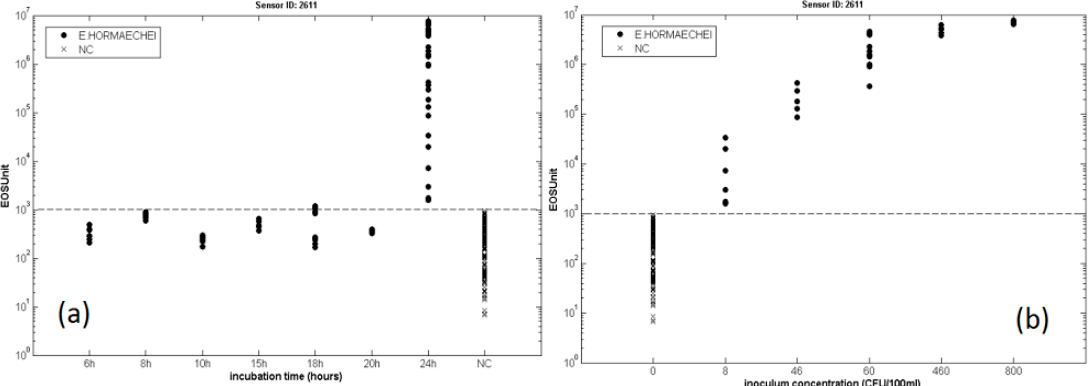
Figure 18. ( a ) plot of the sensor 2611 EOS units against the sample incubation time from 6 h to 24 h. C and NC samples are labelled in different ways (dots vs. crosses); ( b ) plot of the sensor 2611 EOS units as a function of the inoculum concentration (only C samples incubated for 24 h). Reprint from [120], copyright (2014) with permission from Elsevier.